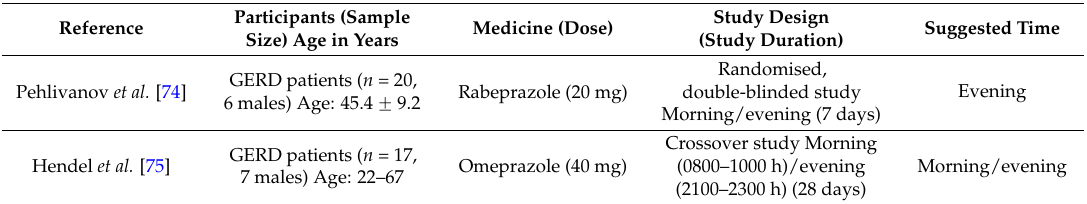
Table 4. Evidence supporting the chronotherapy of proton pump